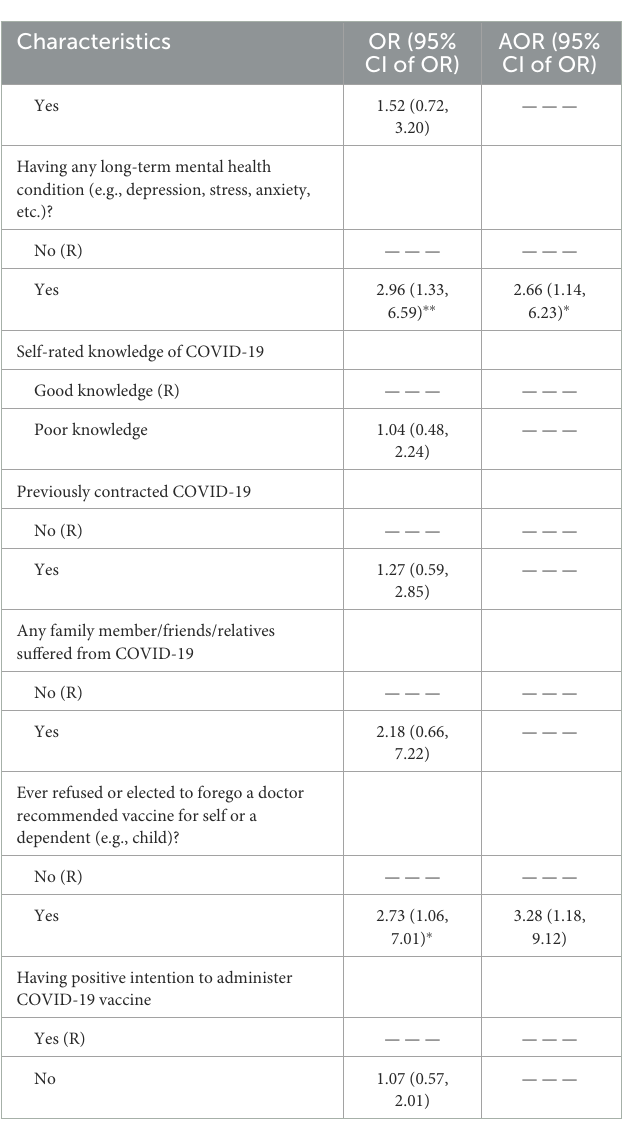
TABLE 4 Determinants of COVID-19